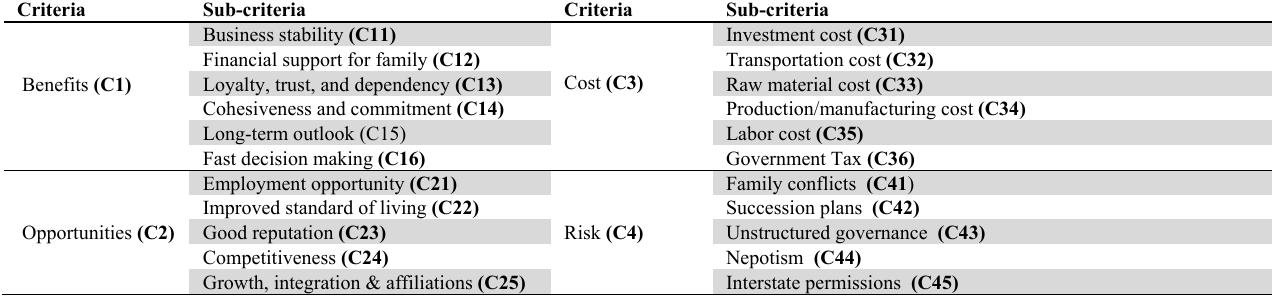
Identified Criteria and Sub-criteria for SME Family